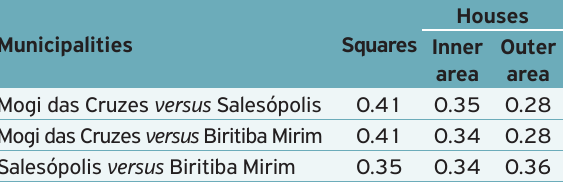
Table 3. Results of the Jaccard similarity index among the different urban centers in Alto Tietê, São Paulo, Brazil.